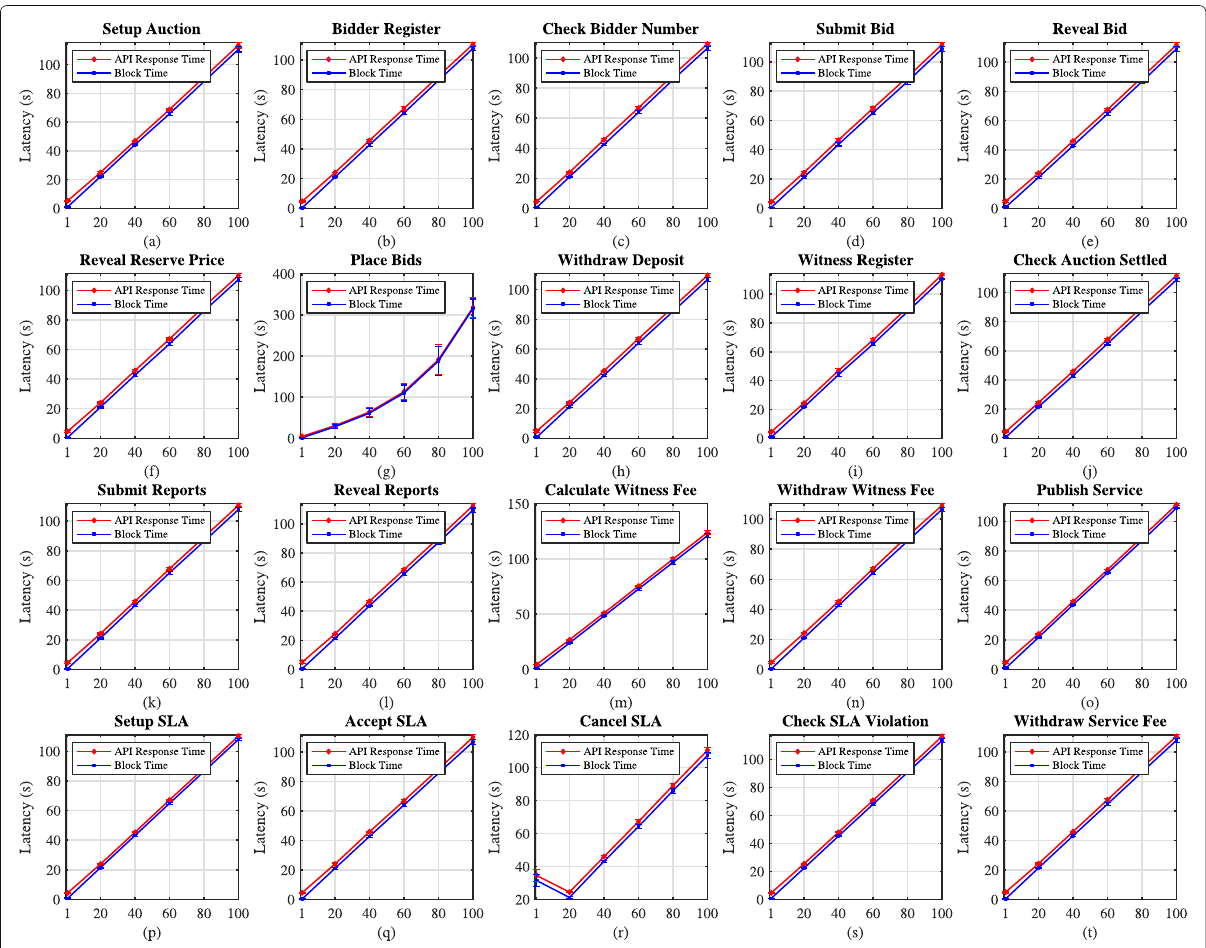
Fig. 13 Execution latency of different function interfaces in AWESOME smart contracts under the average mining network